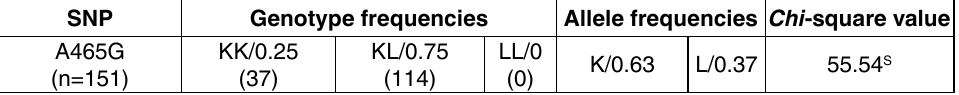
Table 1. Genotype and allele frequencies for SNP A465G in bovine BTN1A1 gene